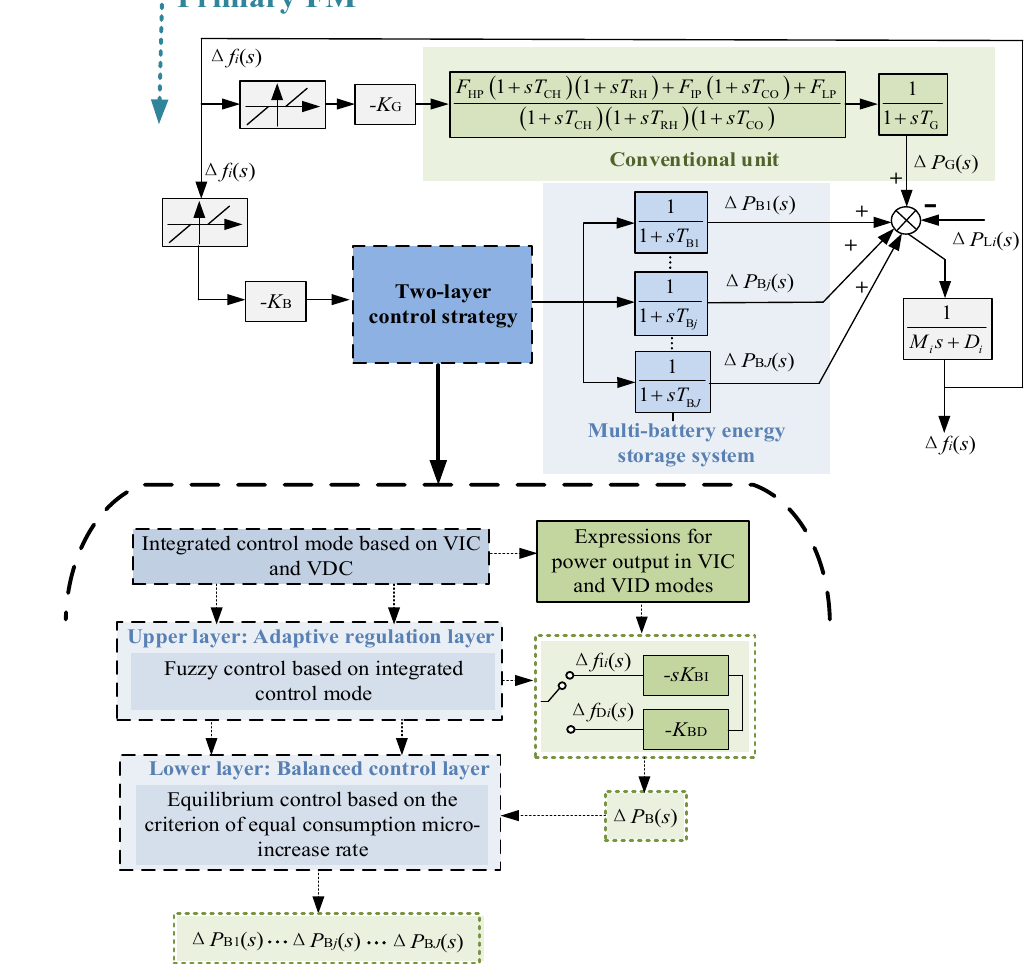
Figure 1. Frequency dynamic response model of region i.